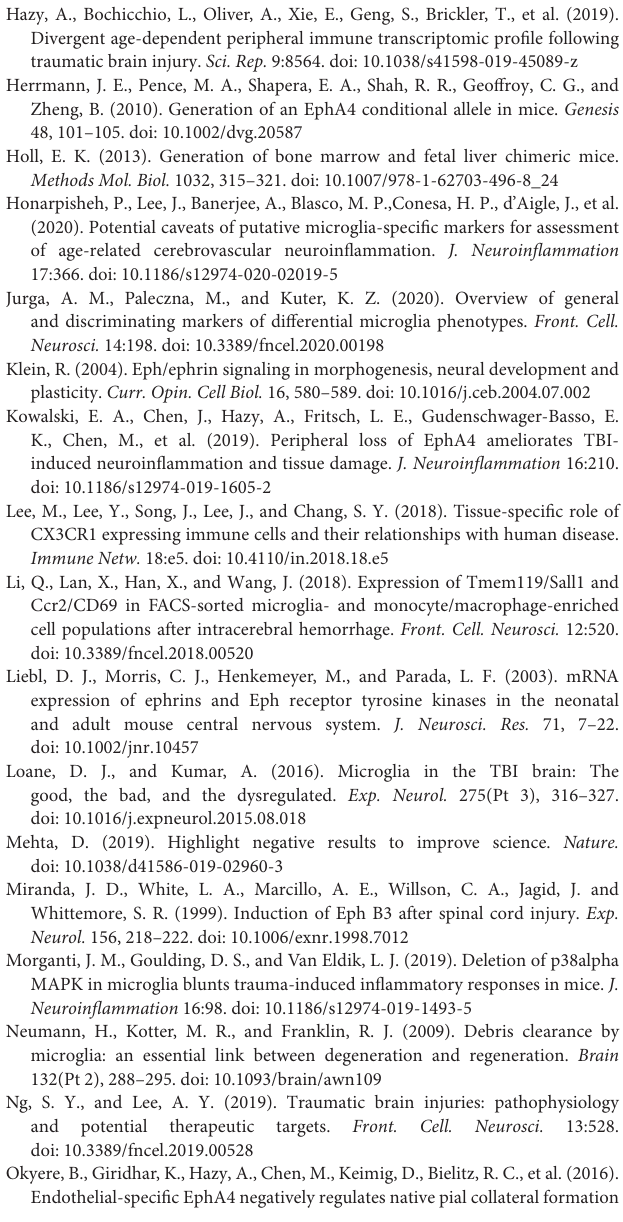
lesion and peri-lesion. EphA4 is not observed on ramified microglia (yellow arrowhead). Scale bar = 100 µ m. Supplementary Figure 2 | Confocal image analysis of the contralateral cortical hemisphere at 3 dpi in GFP-adoptive transfer mice. (A) Merged confocal image max z-projection of Iba1 and GFP in chimeric mice at 3 days post-CCI injury. Individual channel images of GFP (B) and Iba1 (C) . Scale bar 500 µ m. ctx-cortex; cc, corpus callosum. Supplementary Figure 3 | Whole blood EphA4 expression and Cx3cr1 CreER mice genotype, body weight, and cortical mantle thickness. (A) Relative EphA4 mRNA expression in whole blood of naive Cx3cr1 CreER / + EphA4 + / + and Cx3cr1 CreER / + EphA4 f / f at 2 weeks and 1-month post-tamoxifen (TAM) injection. (B) PCR amplification of Cx3cr1-WT allele (695 bp) and Cx3cr1-mutant allele (300